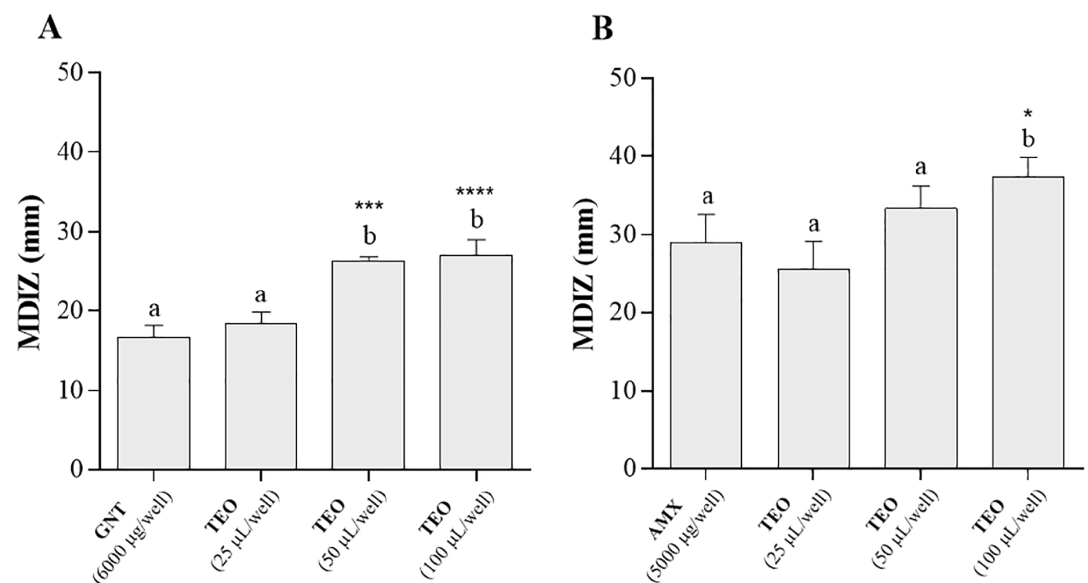
Figure 2. In vitro antibacterial activity of thyme essential oil against S. Typhimurium ST1 ( A ) and B. cereus BC3 ( B ) food isolates. Results were obtained by agar well diffusion method; triplicate assays with independent cultures. The mean diameters of inhibition zone, reported as mean values ± standard deviation (expressed in mm), are graphically represented. One-way ANOVA test was performed to evaluate statistical significance. Bars comparison with positive control bar (absence of TEO) was analyzed by Dunnett’s post hoc test ( p < 0.05), using asterisks to indicate statistical significance respect to the positive control (**** p < 0.0001; *** p < 0.001; * p < 0.05). Tukey’s post hoc test ( p < 0.05) allowed to examine the statistical significance for multiple comparisons between bars. Different letters (a, b) indicate significant differences between bars; bars with no significant differences receive the same letter. MDIZ, mean diameter of the inhibition zone; TEO, thyme essential oil; GNT, gentamicin; AMX, amoxicillin.